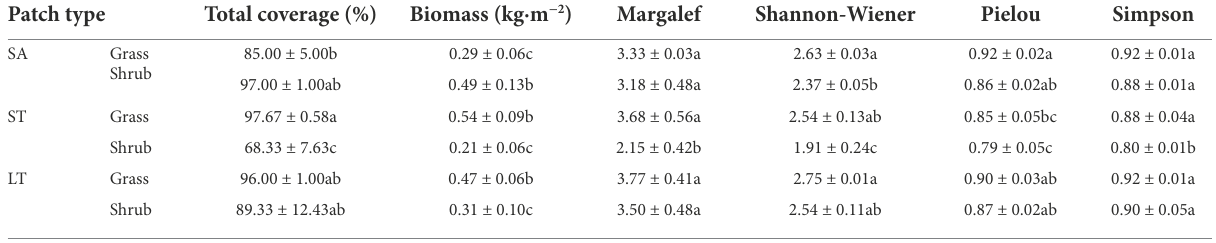
TABLE 2 The plant community characteristics of three species shrub encroachment grasslands.